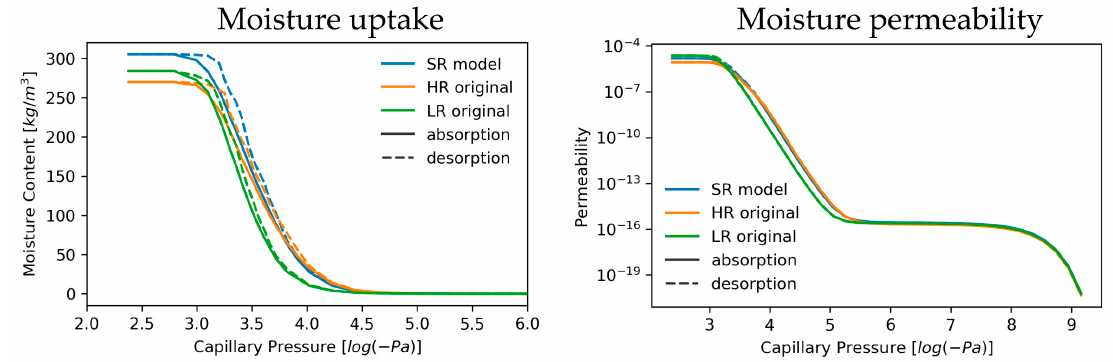
Figure 10. Impact of super-resolved models (SRM) on unsaturated moisture absorption and desorption on moisture permeability (right) and drying (left) with changing capillary pressure. Absorption would increase capillary pressure because this pressure is linked to relative humidity thus following the graphs from right to left. Desorption or drying follows the opposite direction. The di ff erence between the solid and dotted line shows ”hysteresis”. Only data from first volume (V1) is shown and note that the left graph has its x-axes cropped to represent a narrower capillary pressure range than moisture permeability (right plot), because no visible moisture variation occurs in the higher log(-Pa) range. Table 6. Impact of super-resolution models on moisture saturation, saturated moisture permeability and vapour permeability studied for four volumes of 500³ voxels each. Relative difference with expected high-resolution data is added.